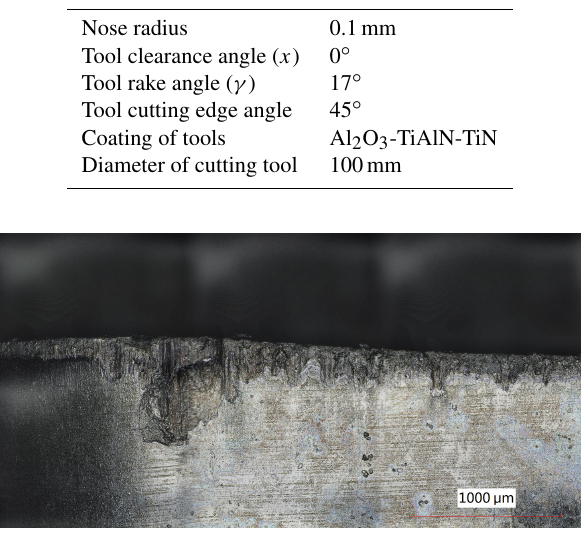
Figure 2. The surface morphologies of tool insert with tool flank wear 0.3mm.